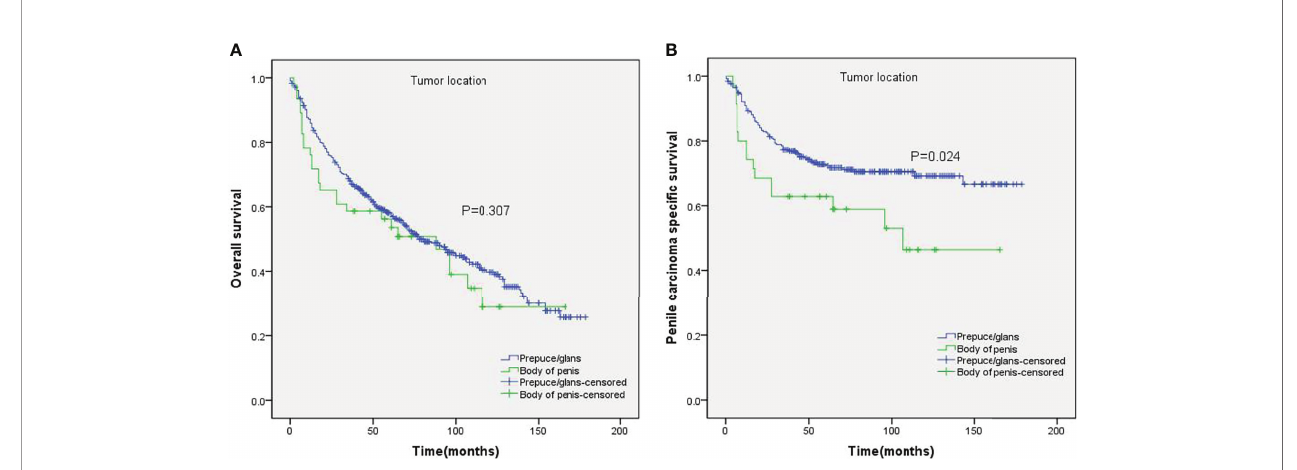
FIGURE 1 | Kaplan – Meier analyses of overall survival (A) and penile carcinoma-speci fi c survival (B) between different tumor